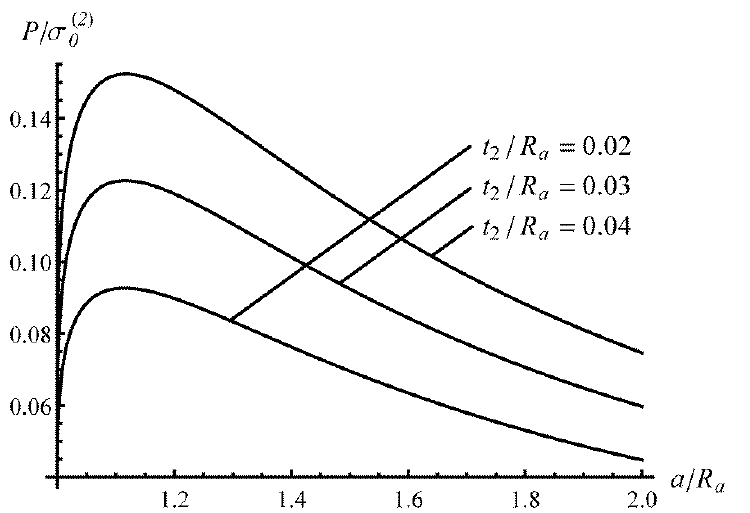
Figure 3. Comparison of the experimental data from [26], and the theoretical solution resulting from Equation (32). The solid line represents the experimental data and the broken line the theoretical solution found using Equation (32).